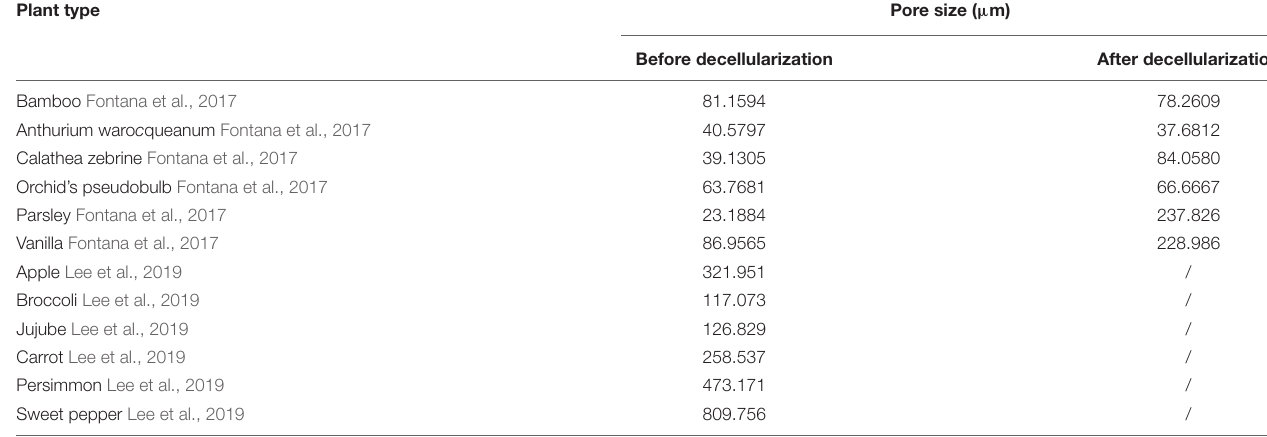
TABLE 3 | The pore size of representative plants before and after